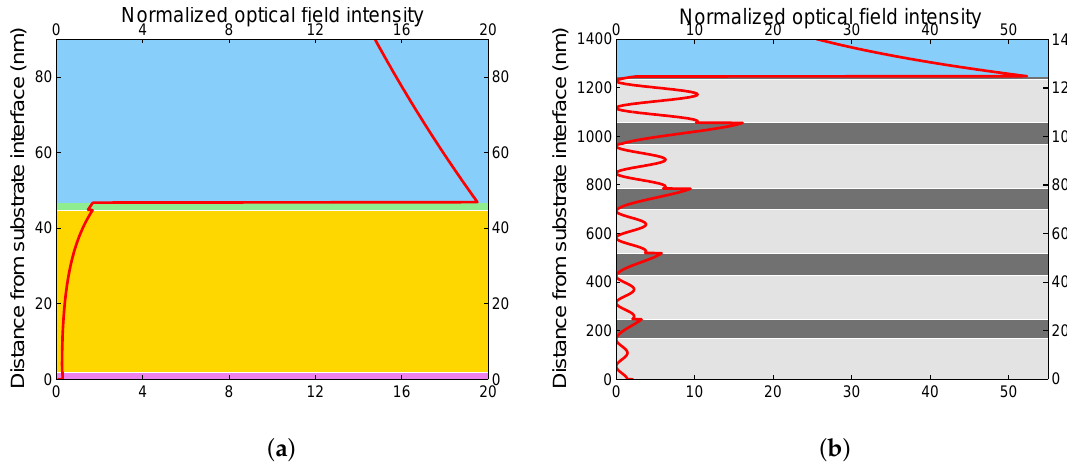
Figure 5. The normalized optical field intensity distribution in the MPS for an angle of incidence of θ = 37.7 ◦ and λ = 641.6 nm ( a ), and in the MDS for θ = 41.9 ◦ and λ = 489.2 nm ( b ). TM wave and analyte is air.